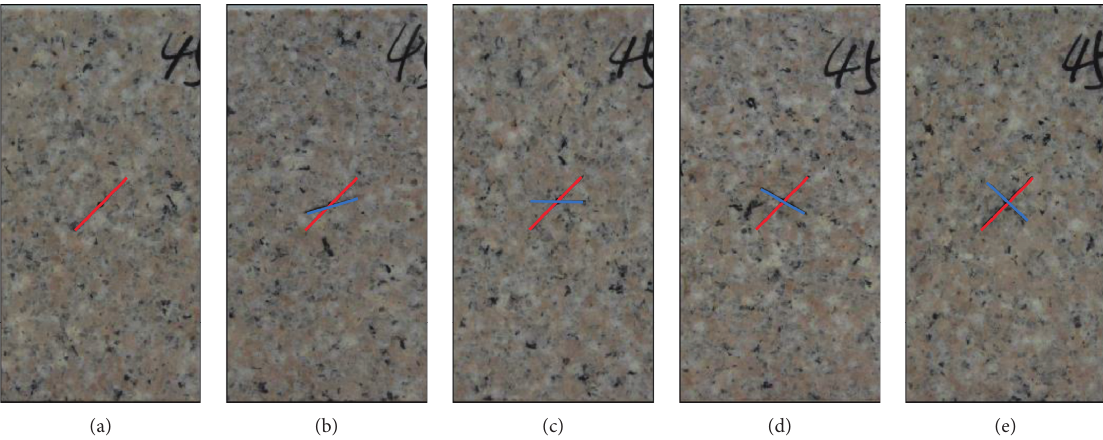
Figure 2: Cross-cracked samples: (a) α � 45 ° , β � 0 ° ; (b) α � 45 ° , β � 30 ° ; (c) α � 45 ° , β � 45 ° ; (d) α � 45 ° , β � 60 ° ; (e) α � 45 ° , β � 90 ° .